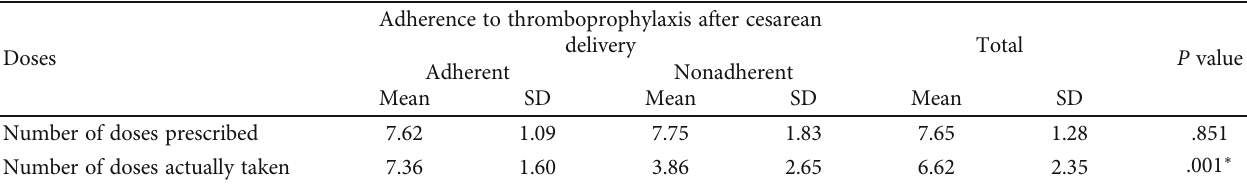
Table 6: Distribution of parturients ’ adherence to LMWH postdischarge by their prescribed and taken doses. Adherence to thromboprophylaxis after Doses